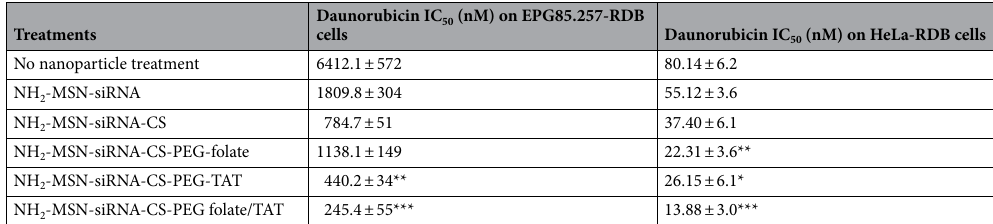
Table 2. IC 50 values of daunorubicin in the presence of 5 µg/ml of each nanoparticle on EPG85.257-RDB and HeLa-RDB cells. Data were expressed as mean ± SD. Stars (*), (**), and (***) represent p < 0.05, p < 0.01, and p < 0.001, respectively. CS Chitosan, PEG polyethylene glycol, TAT trans-activator of transcription.